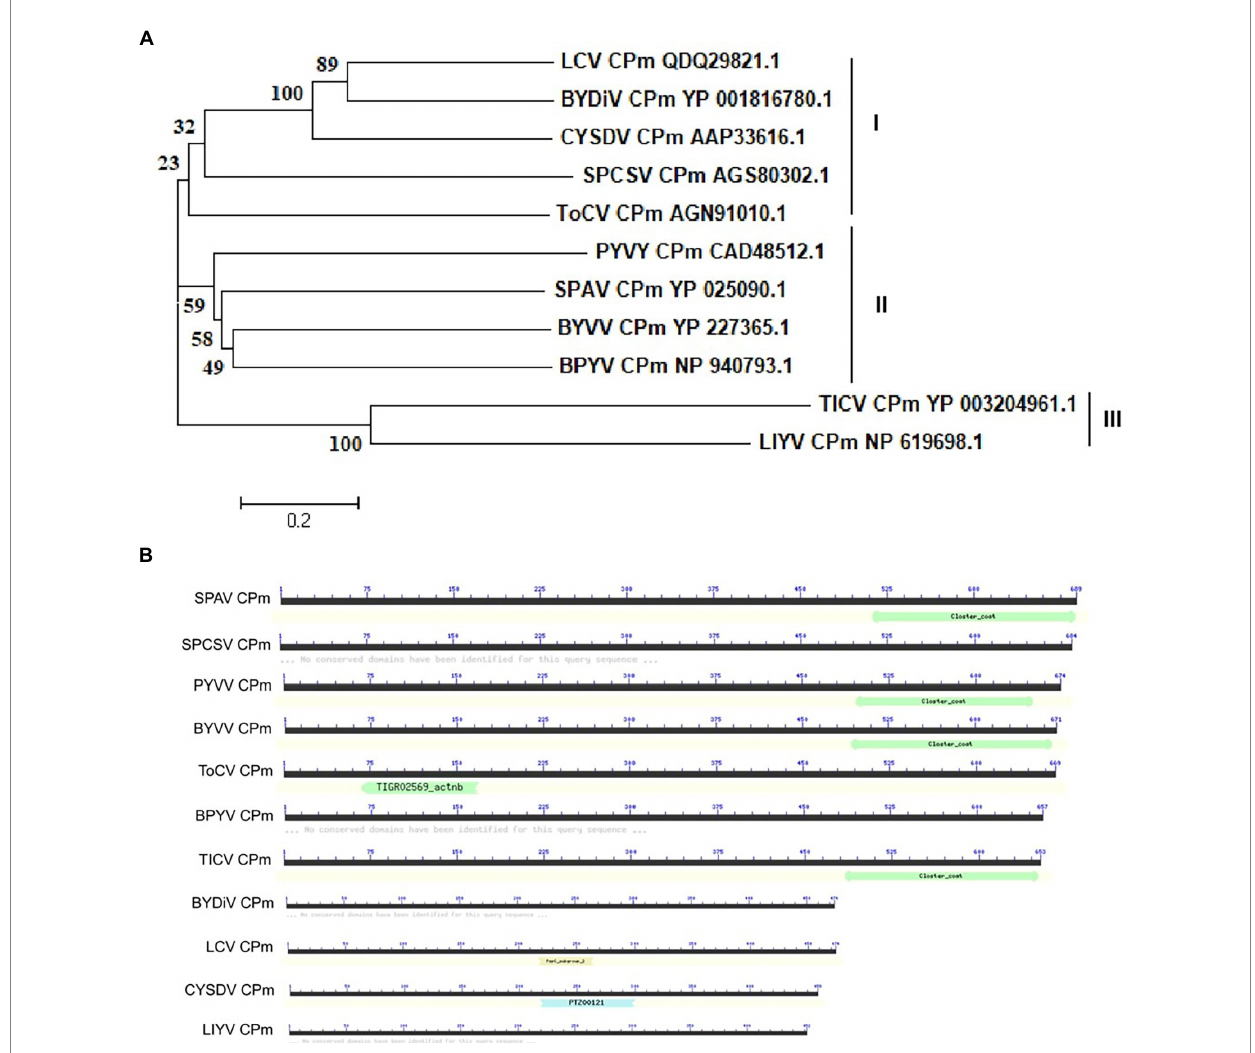
FIGURE 1 Phylogenetic relationships and domain structure of CPm amino-acid sequences of representative criniviruses. (A) The amino-acid sequences of the CPm from 11 criniviruses were aligned using the neighbor-joining method with the MEGA v7.0 program with 1,000 replications. The numbers beside each node represent the percentages for the bootstrap value. The protein accession number in Genbank were shown following virus name. BPYV, Beet psedoyellows virus ; BYDiV, Bean yellow disorder virus; BYVV, Blackberry yellow vein-associated virus; CYSDV, Cucurbit yellow stunting disorder virus ; LCV, Lettuce chlorosis virus; LIYV, Lettuce infectious yellows virus ; PYVV, Potato yellow vein virus; SPAV, Strawberry pollidosis-associated virus ; SPCSV, Sweet potato chlorotic stunt virus; TICV, Tomato infectious chlorosis virus; ToCV, Tomoto chlorosis virus ; (B) The conserved peptidase domain was identified using the Conserved Domain Database